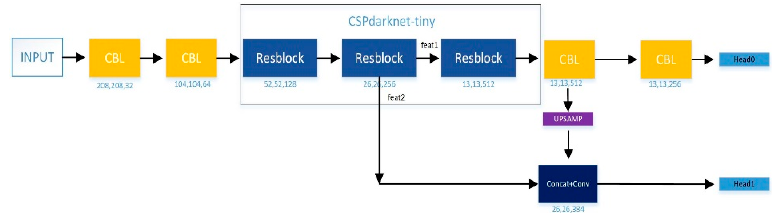
Figure 1. YOLOv4-tiny network structure.